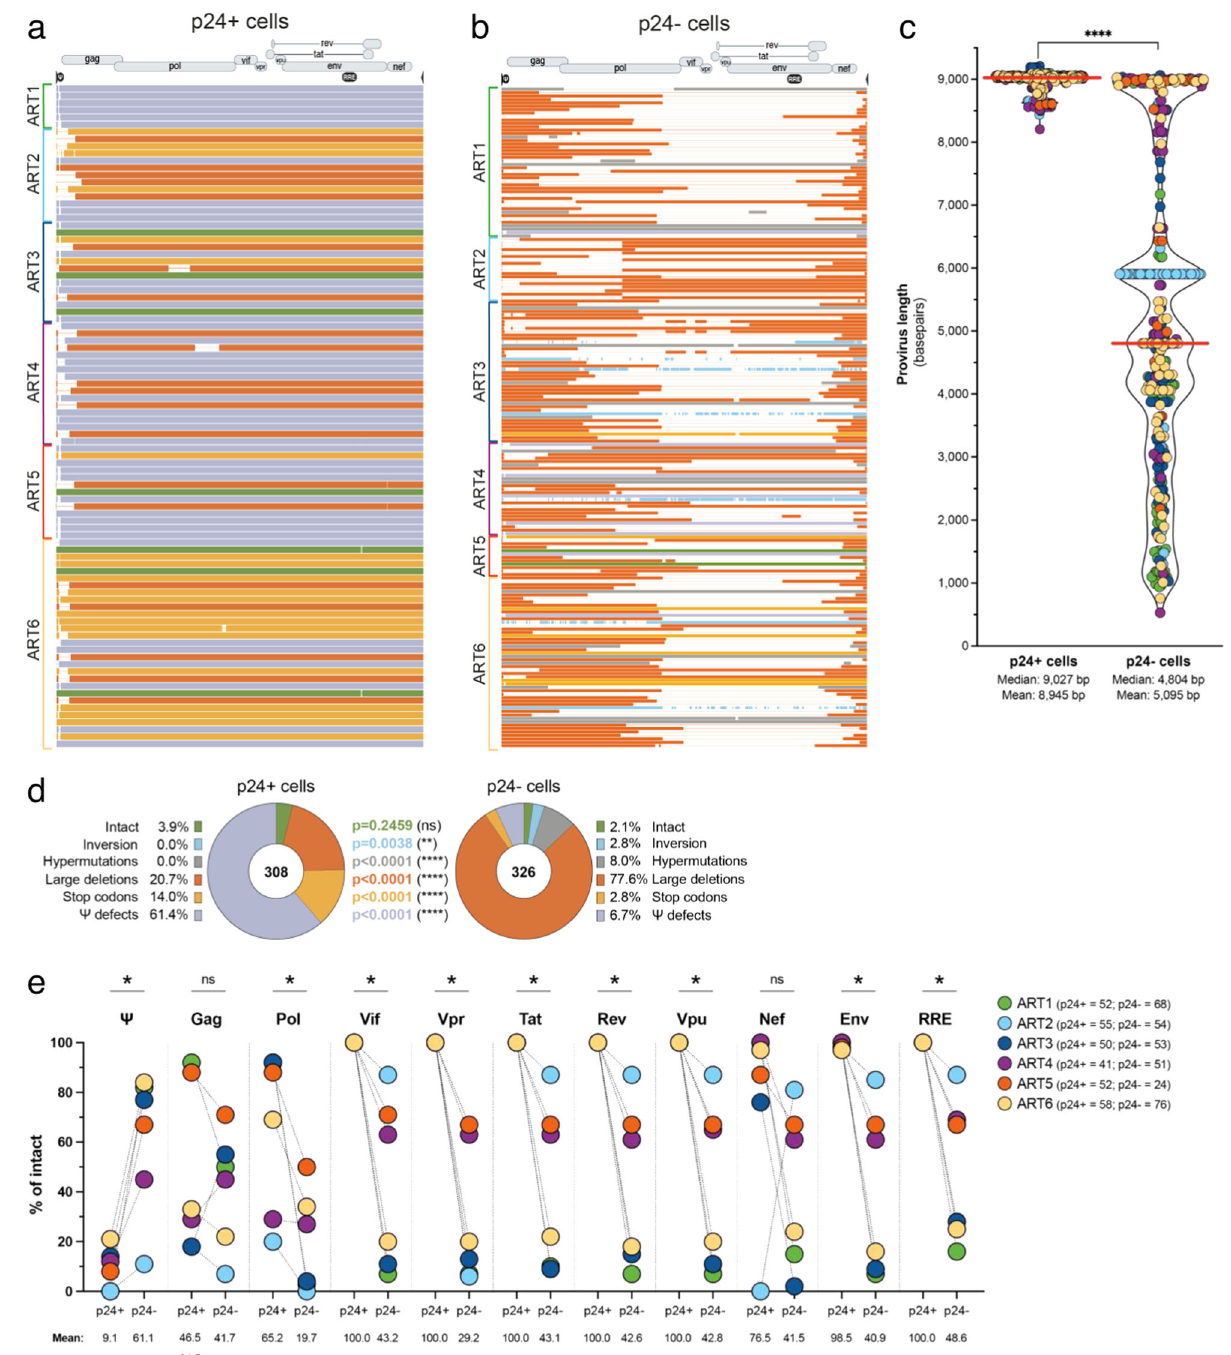
Fig. 5 | Near full-length proviral sequencing and integrity analysis of HIV gen- omesretrievedfromp24+andp24 − cells. HIVgenomesobtainedfromp24+cells ( a ) and p24 − cells ( b ) from the 6 participants were aligned to the annotated HXB2 reference sequence. Each sequence is color-coded according to its integrity cate- gory (see legend in 5d). Clonally expanded proviruses are only displayed once. c Lengths of individual HIV genomes retrieved from p24+ and p24 − cells are plotted: Each dot corresponds to a proviral sequence and is color-coded by parti- cipant (see legend in 5e). The median of each violin plot is represented by a red horizontalline,andthemeanandmedianvaluesareindicatedatthebottomofthe graph. Difference in the length of HIV genomes between p24+ and p24 − popula- tionswasassessedbytheKolmogorov-Smirnovtest(**** p <0.0001). d Proportions